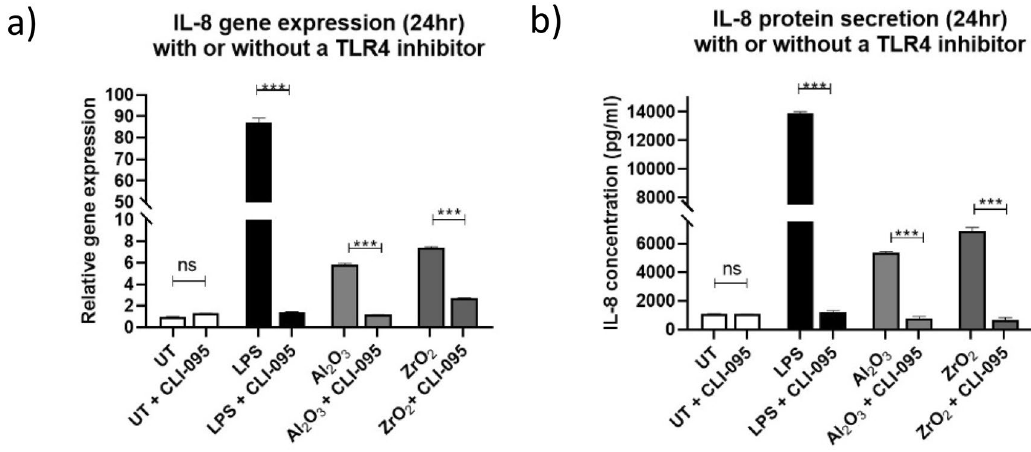
Figure 5. IL-8 relative gene expression and protein secretion following treatment with 50 µm 3 per cell Al 2 O 3 or ZrO 2 with or without a pre-incubation with CLI-095. THP-1 macrophages were activated with PMA and pre- treated with CLI-095 for 6 h, a small-molecule inhibitor of TLR4, prior to a 24 h treatment with 50 µm 3 particles per cell Al 2 O 3 or ZrO 2 . ( a ) Relative gene expression of IL-8 was assessed using RT-qPCR. THP-1 macrophages which were pre-treated with CLI-095 and then treated with 10 ng/mL LPS for 24 h experienced significant decreases in IL-8 relative gene expression (P < 0.0001). Al 2 O 3 -treated cells which received CLI-095 also showed a significant decrease in IL-8 relative gene expression compared to those which did not have a CLI-095 pre- treatment (P = 0.0070). There was a significant decrease in IL-8 relative gene expression in cells which received CLI-095 followed by ZrO 2 (P = 0.0065). ( b ) Supernatant was collected from THP-1 macrophages and used in conjunction with ELISA to quantify IL-8 protein secretion. There was a significant decrease in IL-8